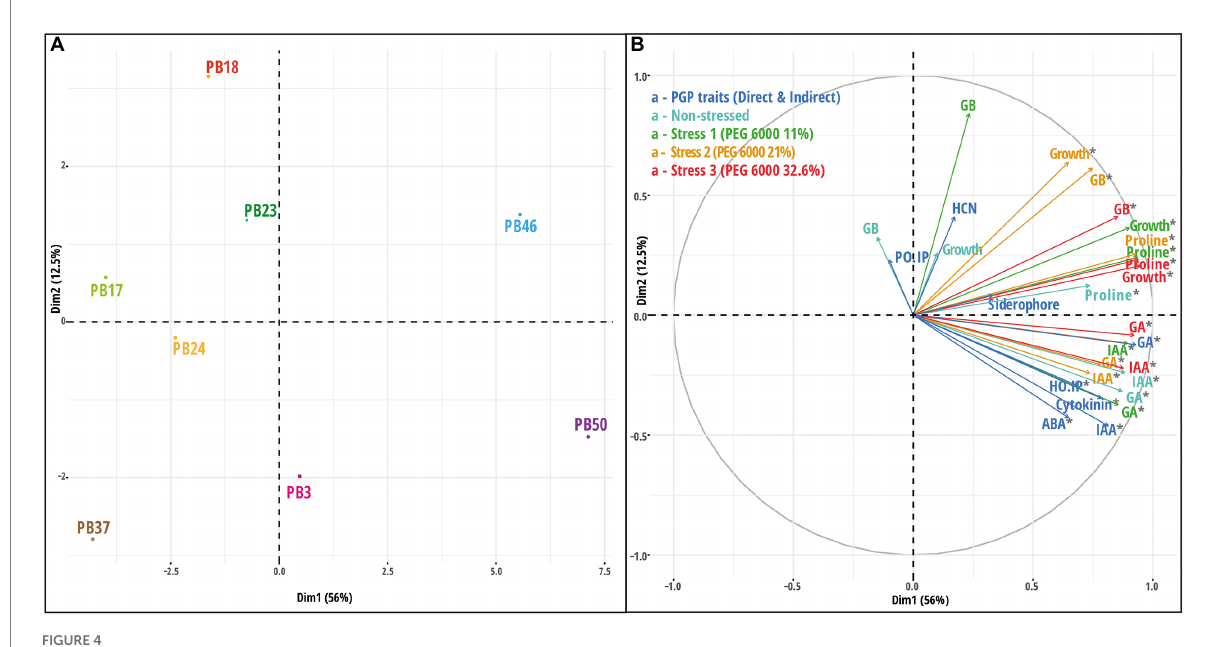
FIGURE 4 Results of principal component analysis (PCA) based on the integration of plant growth-promoting traits data and osmotic stress response parameters datasets. (A) Score plot and (B) loading plot of variables according to first two principal components. The plots correspond to 68.5% of the total data variance, and variance proportions are shown along each principal component axis. Variables with asterisk in the plot (B) are significant along the first principal component axis. Abbreviations used in plot (B) are, indoleacetic acid (IAA), gibberellic acid (GA), glycine betaine (GB), abscisic acid (ABA), hydrogen cyanide (HCN), Helminthosporium oryzae inhibition percentage (HO.IP), and Pyricularia oryzae inhibition percentage (PO.IP). The codes of the strains in plot (A) refer to the following strains: Bacillus endophyticus PB3, B . australimaris PB17, B . pumilus PB18, B . safensis PB23, Staphylococcus sciuri PB24, B . altitudinis PB37, B . altitudinis PB46, and B . megaterium